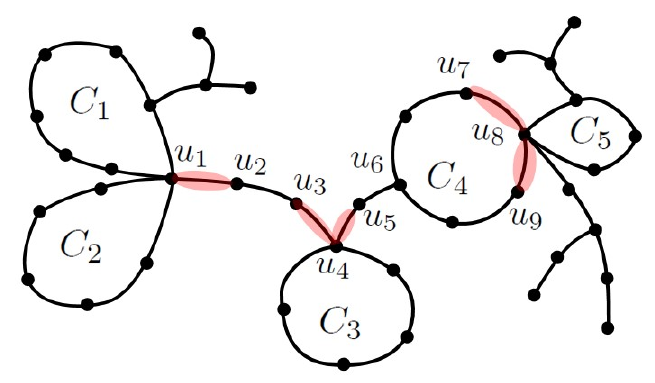
. The end-grape G u and G u has two 1 8 1 consists of one unicyclic and one acyclic berry and it has two 8